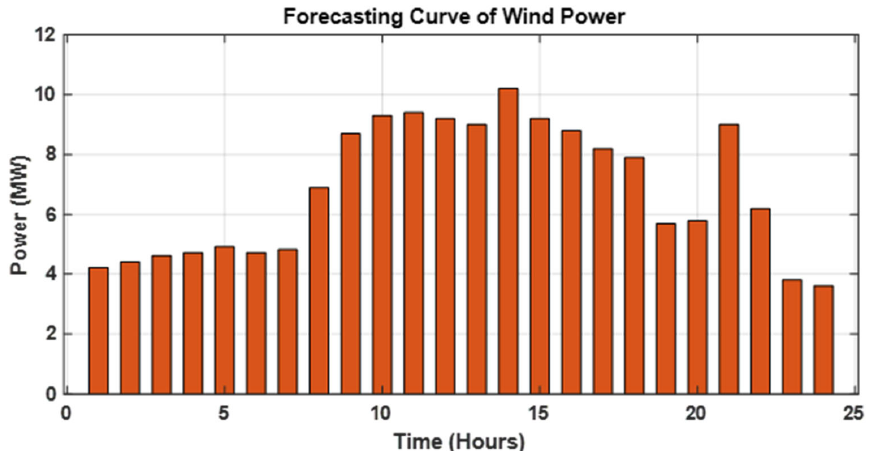
Figure 7. The forecasting curve of wind power generation.